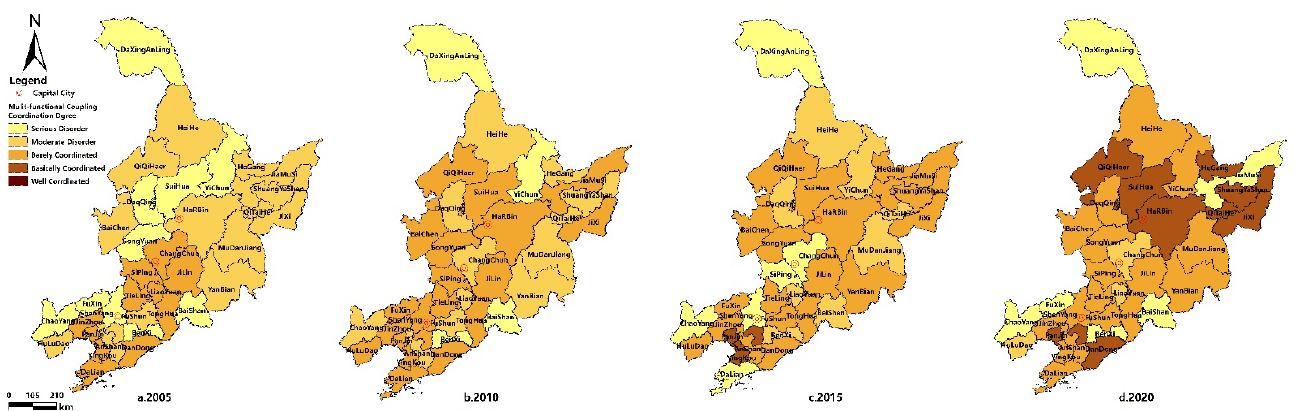
Figure 4. Spatial-temporal distribution of ecological function of cultivated land in 2005, 2010, 2015, and 2020.